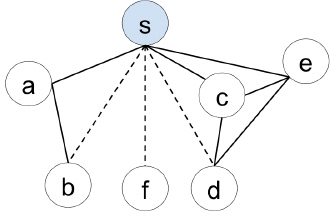
Figure 1. An illustration of automatic research collaboration recommendation. The graph shows a co-authorship network in which the nodes are authors and the links represent co-authorship. The solid lines represent existing co-authorships. Our study is to build a computational model to predict whether author s will collaborate with authors b , f , and d based on their existing research and collaborations.